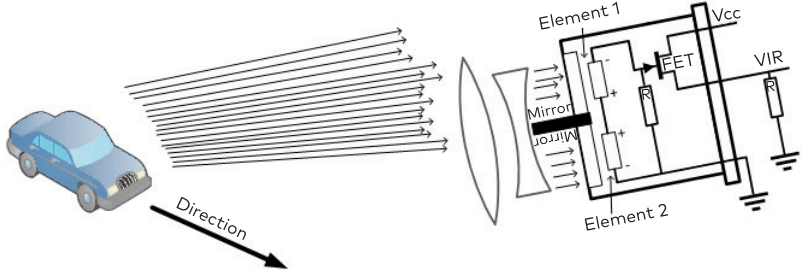
Modified PIR Reverse Plano Convex Frezne I Lens Baffle